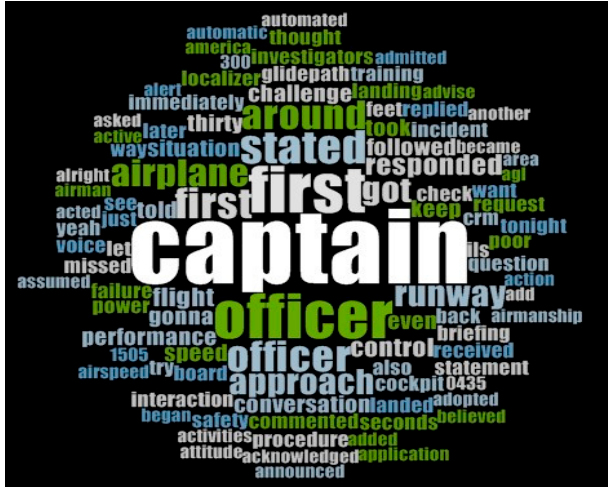
Figure 5. Tag cloud helps visualize word query for Peer Pressure.